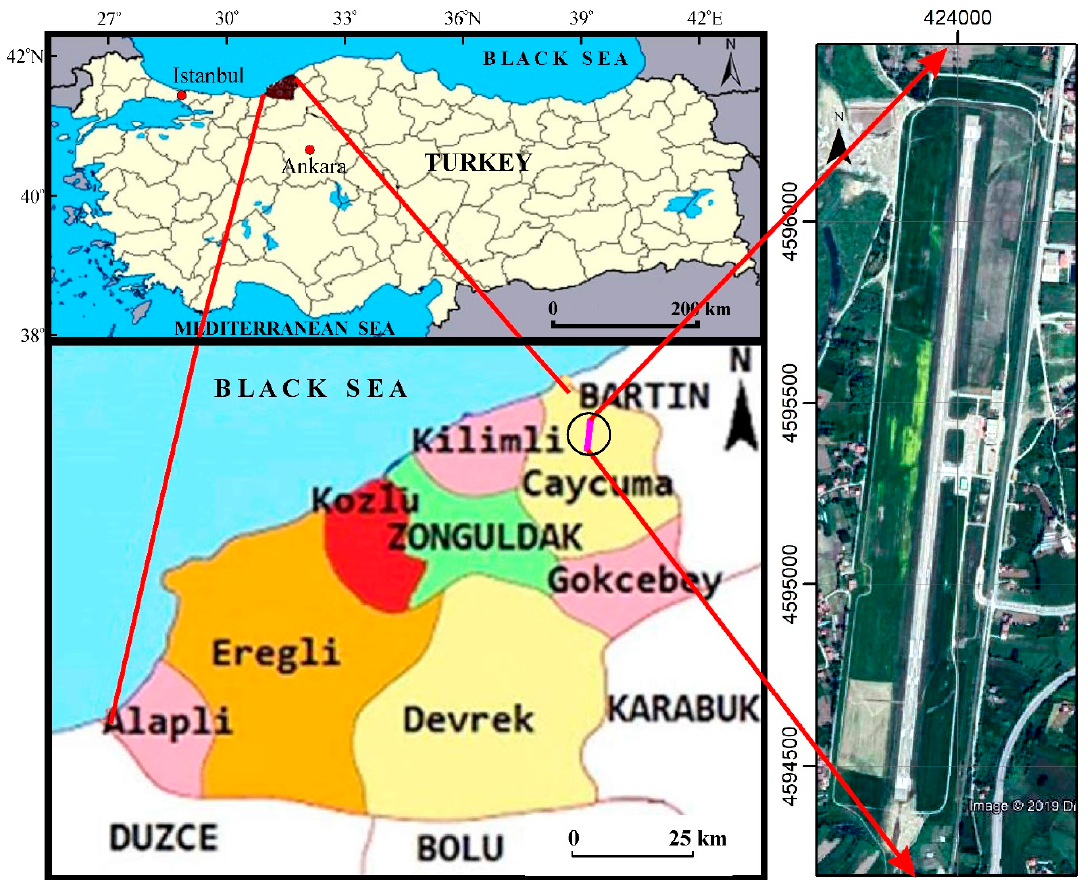
Figure 1. Location of Zonguldak Airport, including its runway (18–36). Source: Image: Google Earth®; Maps: own work. Coordinates: WGS84/UTM36T.